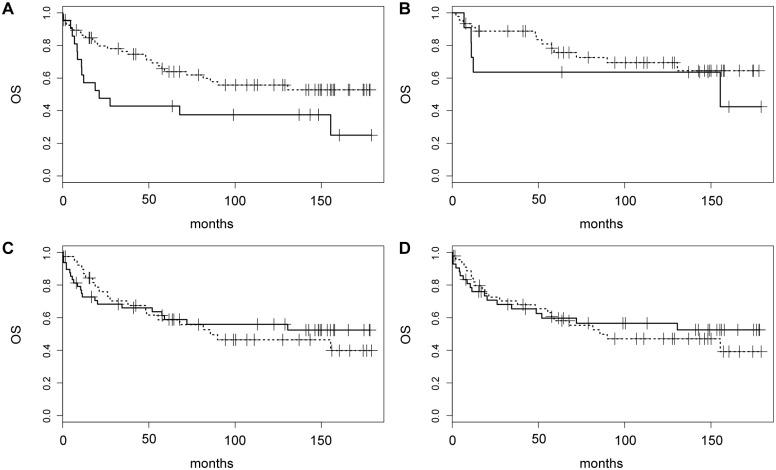
Kaplan-Meier analysis of overall survival (OS) based on DEL and BCR classification.(A) OS for DEL (solid) vs. non-DEL (dashed) cases (p = 0.03) among all patients with available follow-up. (B) OS for DEL (solid) vs. non-DEL (dashed) cases restricted to R-CHOP-treated patients. (C) OS for BCR+ (solid) vs. BCR- (dashed) cases according to the revised definition for BCR positivity. (D) OS for cases with Fcyt>50 (solid) vs. Fcyt<50 (dashed).